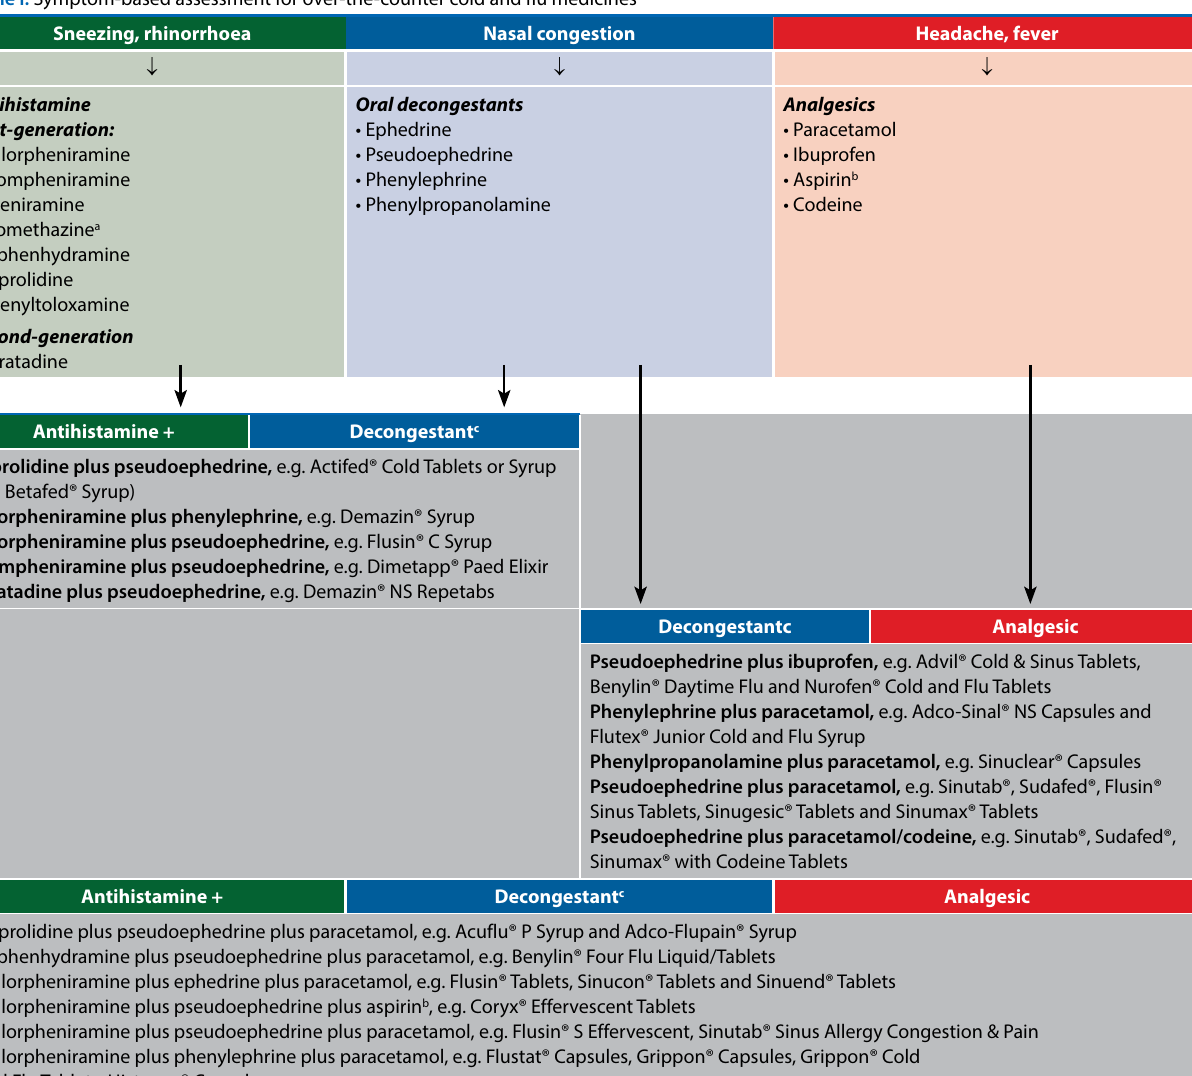
Antihistamine First-generation: